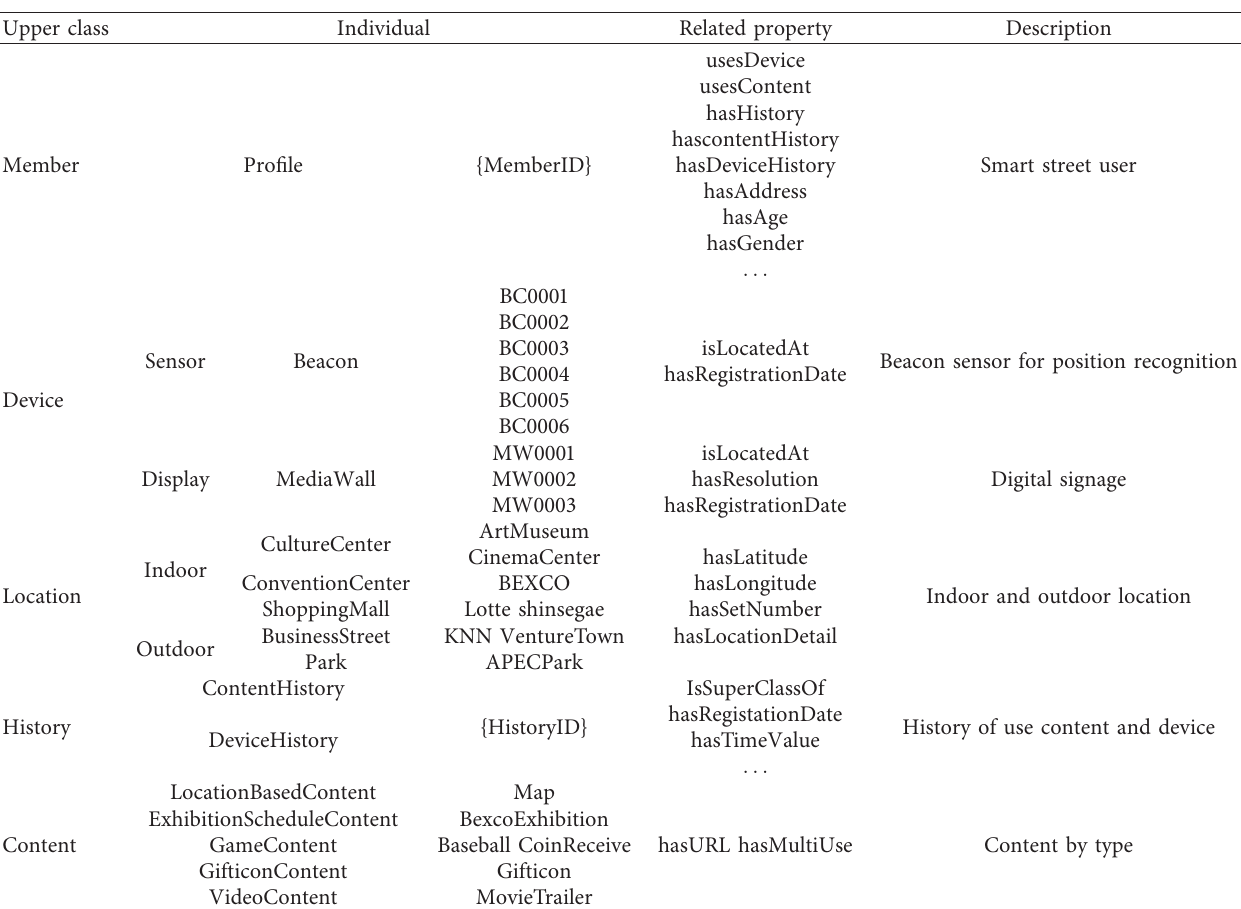
Figure 5: Typical scenario for a content service Table 3: Ontology mapping element.